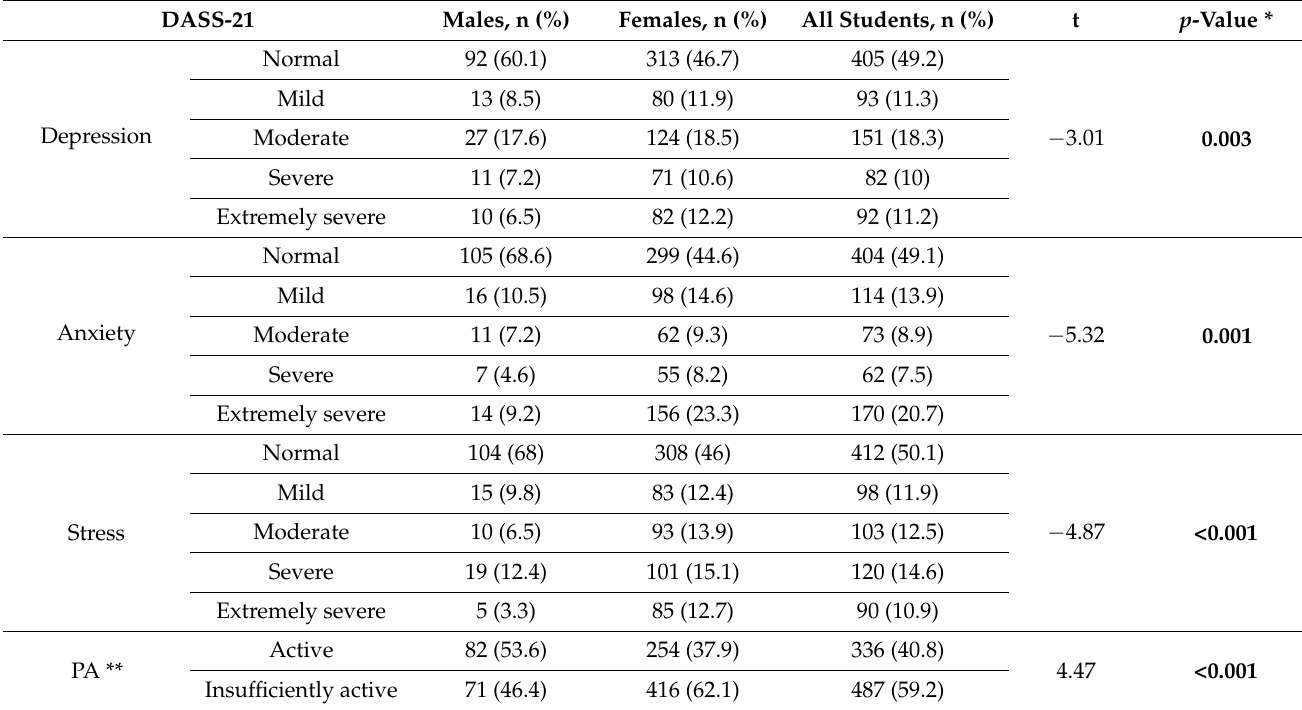
Table 7. The prevalence of the categories of depressive, anxiety, and stress symptoms according to the DASS-21 and GSLTPAQ. Groups are divided by gender (N =